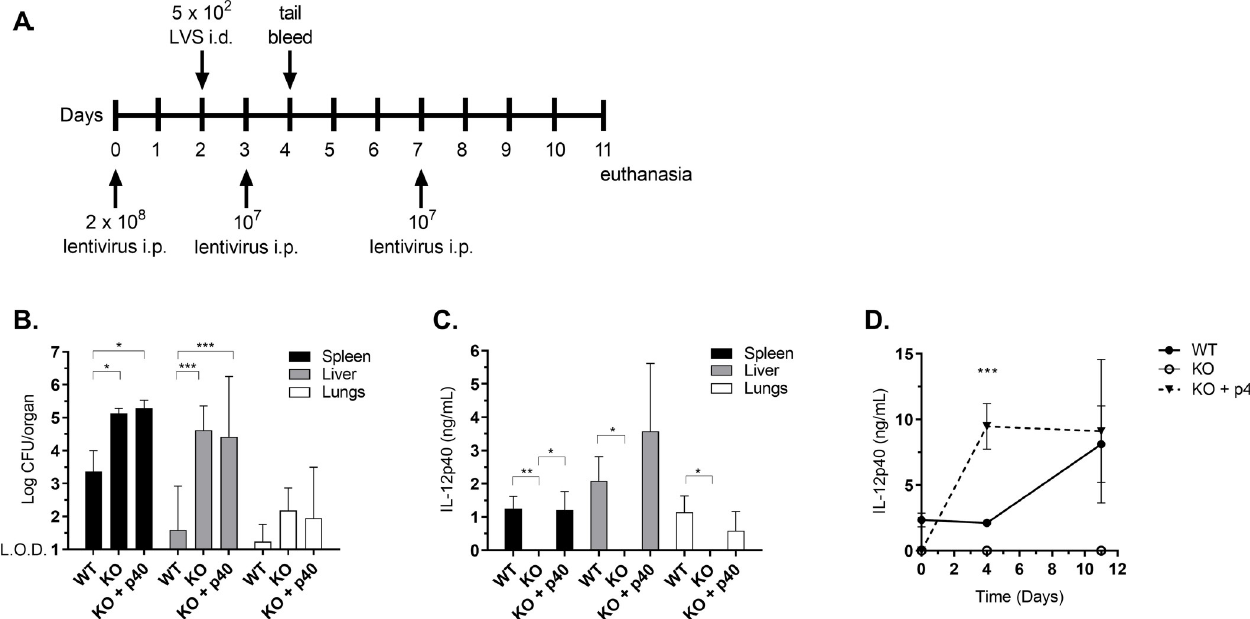
Fig 3. Administration of IL-12p40-overexpressing lentivirus does not rescue p40 KO mice from chronic infection. The indicated mice were given 2 x 10 8 pHAGE-Il12b2 lentivirus or PBS i.p. on day 0, then challenged with 5 x 10 2 LVS or PBS i.d. on day 2 (A). Mice were then given two additional treatments of 10 7 lentivirus or PBS i.p. at days 3 and 7. Bacterial burdens were determined on day 11 (B) and IL-12p40 expression was determined by ELISA in spleen, liver, lungs (C), and sera (D). Data are from a representative of five independent experiments of similar design. Mice used were ages 4–9 months and were aged matched within each experiment. � p < 0.05; �� p < 0.01; ��� p < 0.001 between KO + p40 and WT by ANOVA with Tukey’s multiple comparisons test.